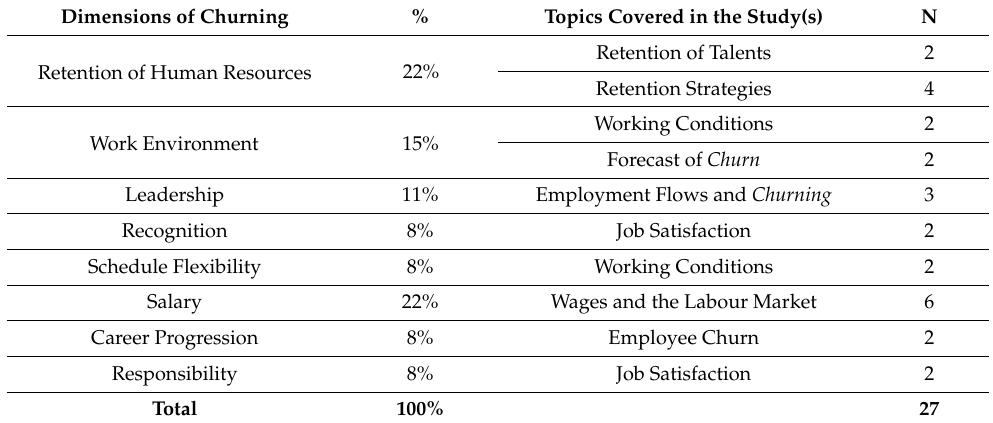
Table 1. Empirical articles regarding the churning of human resources published between 2004 and 2021.